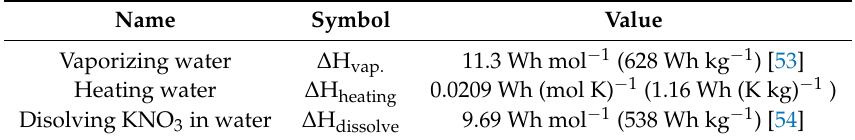
Table 5. Input enthalpy values used to model power density and hydrogen production from RED.